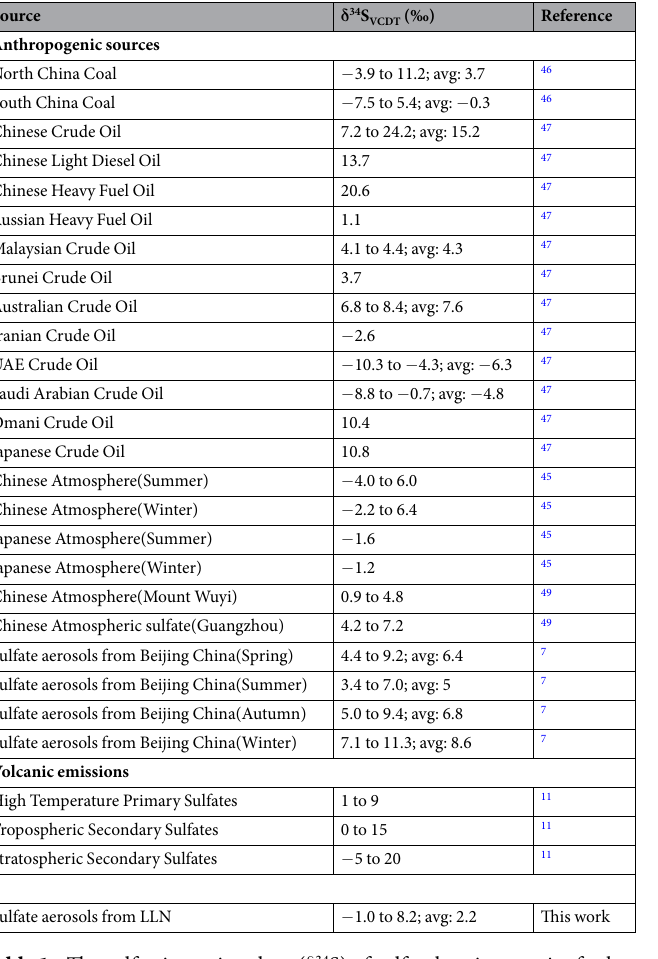
Table 1. The sulfur isotopic values ( δ 34 S) of sulfur-bearing species for known emission sources. Oceanic Dimethyl sulfide has a value of δ 34 S around 21‰ (ref. 13